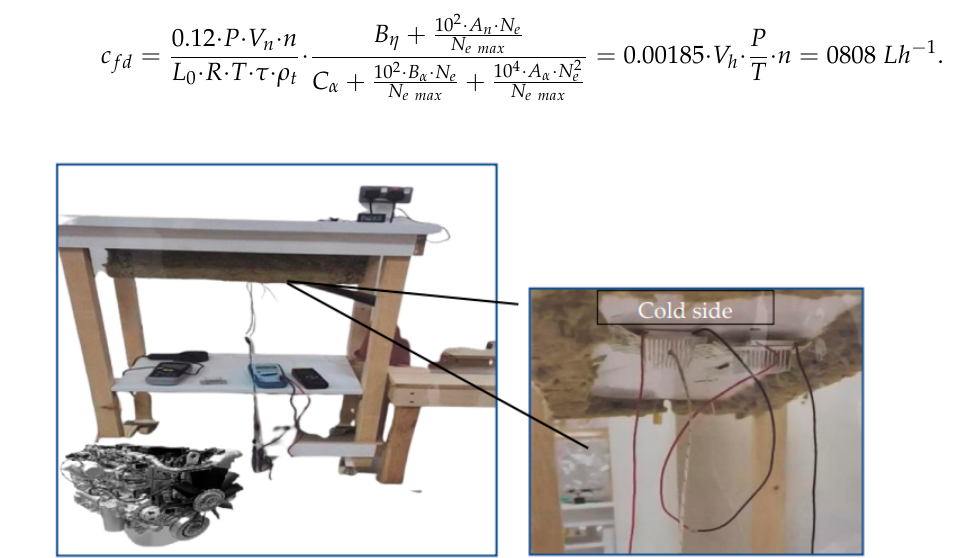
Figure 21. The TEG-ICE integration laboratory and observe 45 gaskets through 23 weeks. Figure 22 illustrates the fuel consumption reflected on generated electricity power (W) and shown in Figure 23, which if reduced as appeared after 5 working weeks, the experiment stops and unfixes the gasket and records the cracks’ position and intensity by filming and installing the thermal conductivity strips in another path far away from the direction of the cracks. Therefore, an increase in power is observed until week #9, which is observed as a steady-state behavior to week #20, then reduced again to week #23. The experiment again stops and analyzes all filming shots to discover the cracks’ behavior.